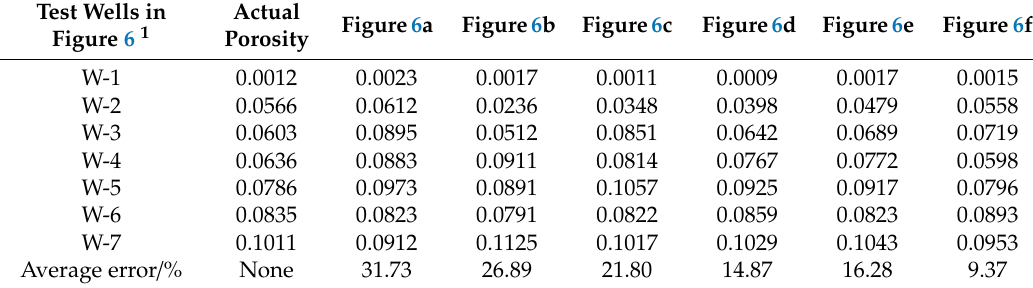
Figure 6. Porosity model of the X area in Karamay, Xinjiang, China: ( a ) porosity model simulated by the conventional sequential Gaussian simulation method; ( b ) porosity model simulated by the facies-controlled conventional sequential Gaussian simulation method; ( c ) porosity model simulated by the DFNN-based reservoir geological modeling method; ( d ) porosity model simulated by the DFNN-based facies-controlled reservoir geological modeling method; ( e ) porosity model simulated by the DFNN-based non-facies-controlled well-seismic combined reservoir geological modeling method; ( f ) porosity model simulated by the DFNN-based facies-controlled well-seismic combined reservoir geological modeling method; ( g ) 3D porosity model of the X area in Karamay, Xinjiang, China; and ( h ) 3D perspective porosity model of the X area in Karamay, Xinjiang, China. Table 3. Test well experiment for porosity modeling based on di ff erent methods. Test Wells